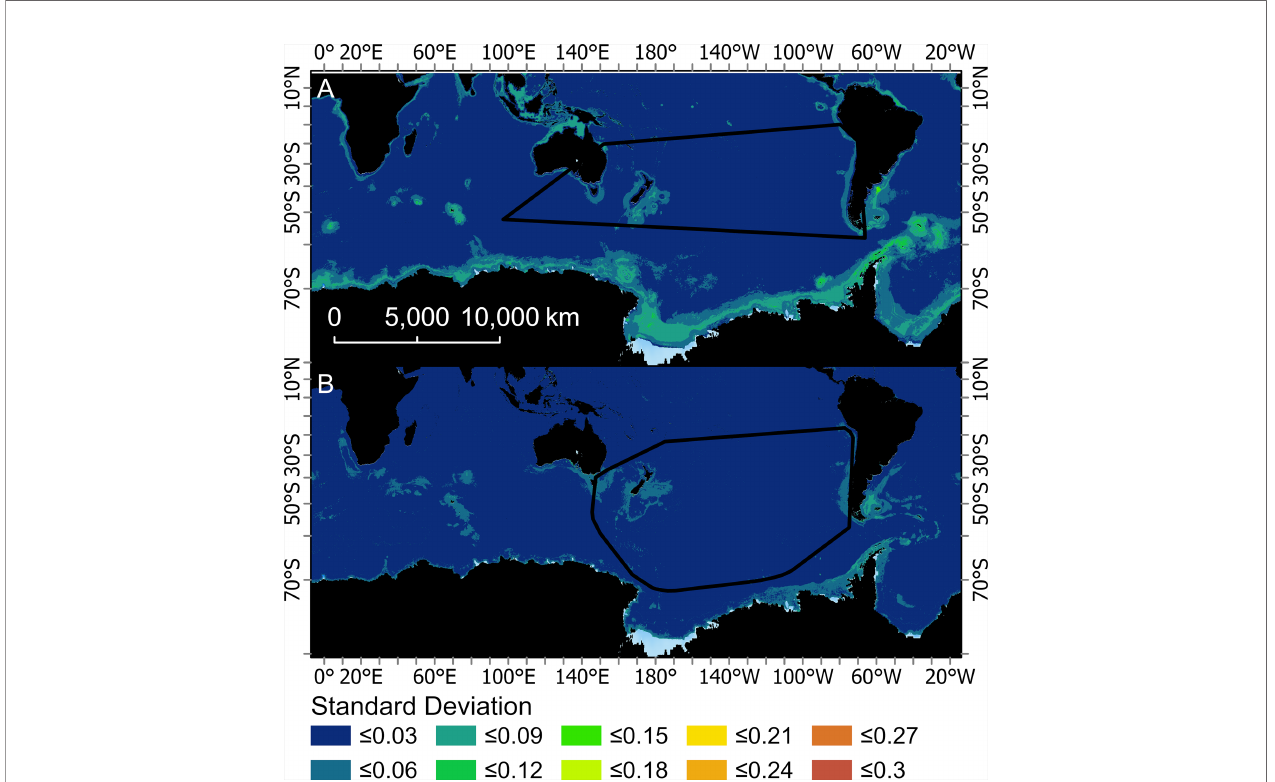
FIGURE 4 | Mean of the monthly standard deviations created from the 200 bootstraps for two boosted regression tree models used to predict the probably of occurrence for Buller ’ s albatross (one fi t with opportunistic sightings data [BRT OS , (A) ], and one fi t with geolocation data [BRT GL , (B) ]. Black boundaries indicate the minimum convex hull around the data that were used to fi t each respective BRT model.